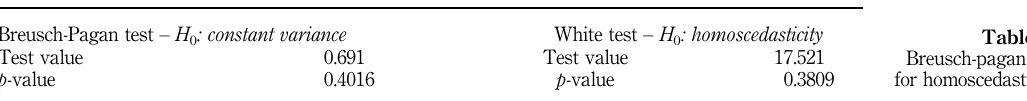
Table V. Breusch-pagan